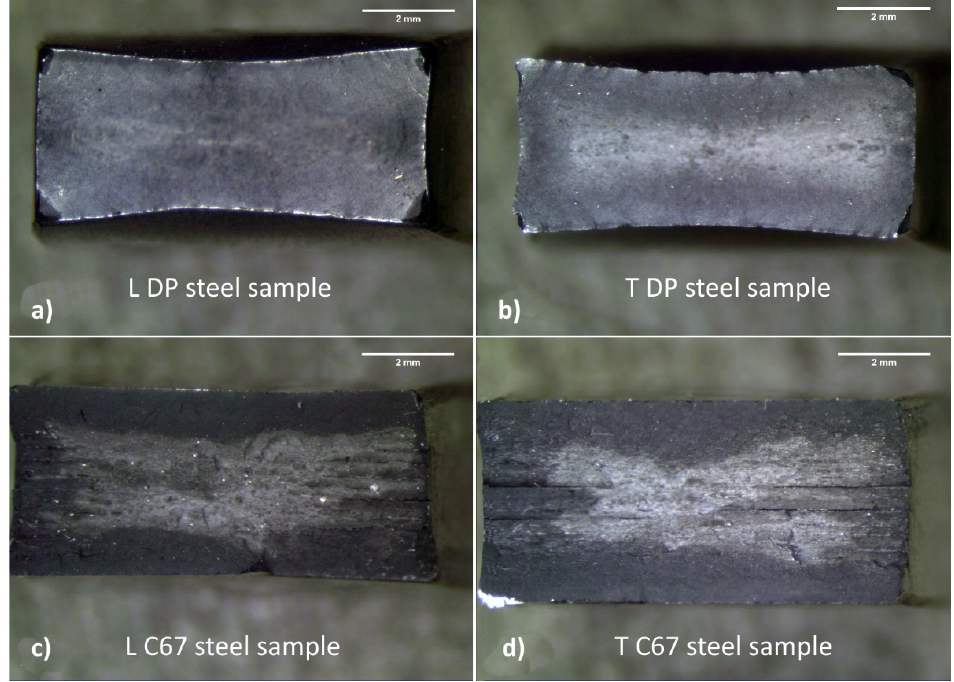
Figure 5. Broken tensile samples under stereomicroscope; DP steel ( a , b ) shows more deformed edges compared to C67 ( c , d ).